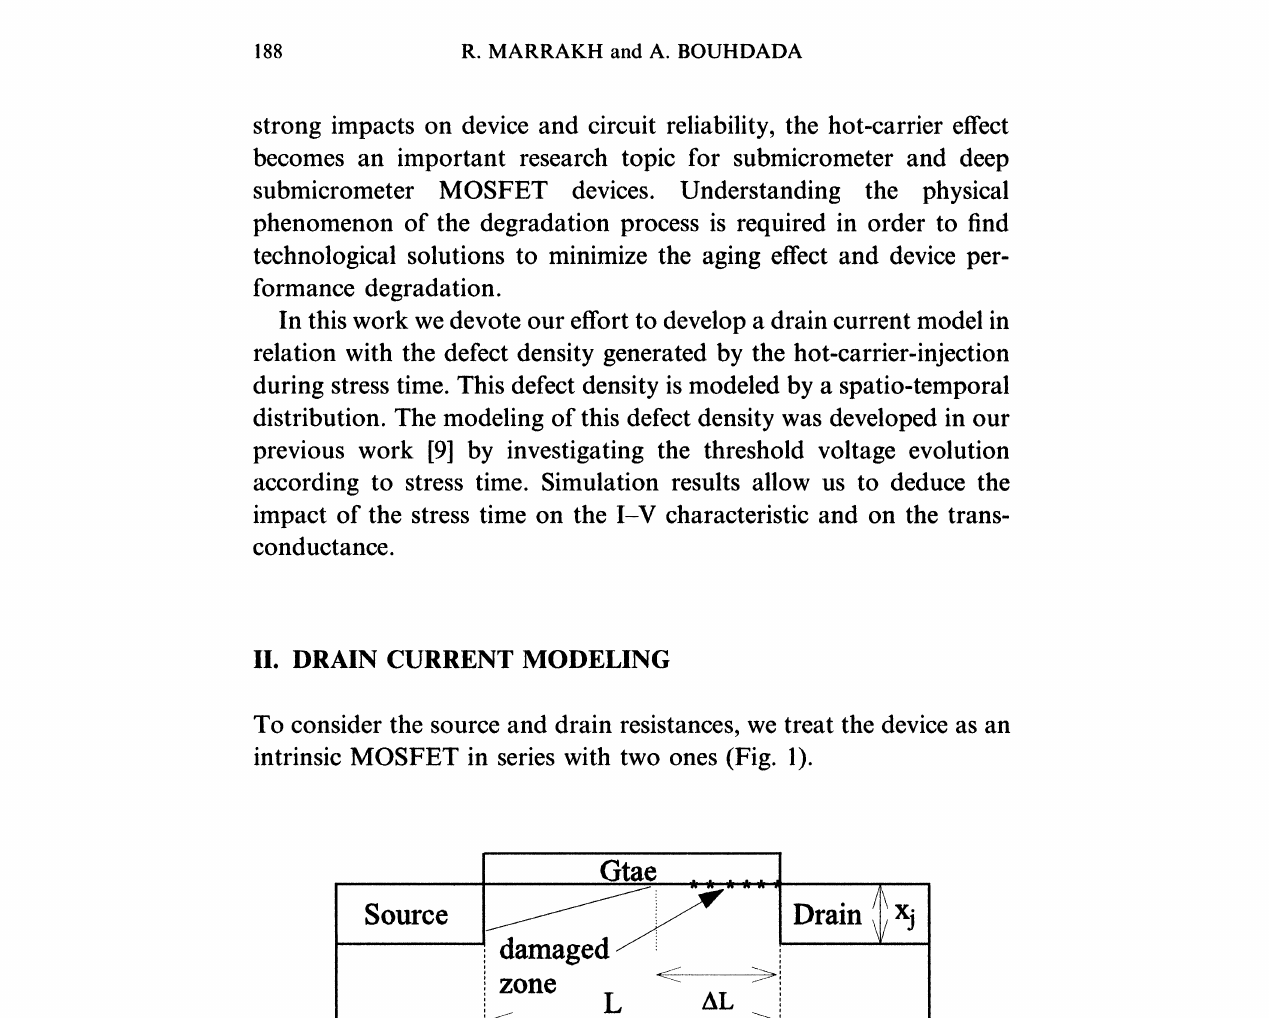
FIGURE Schematic diagram and equivalent circuit of